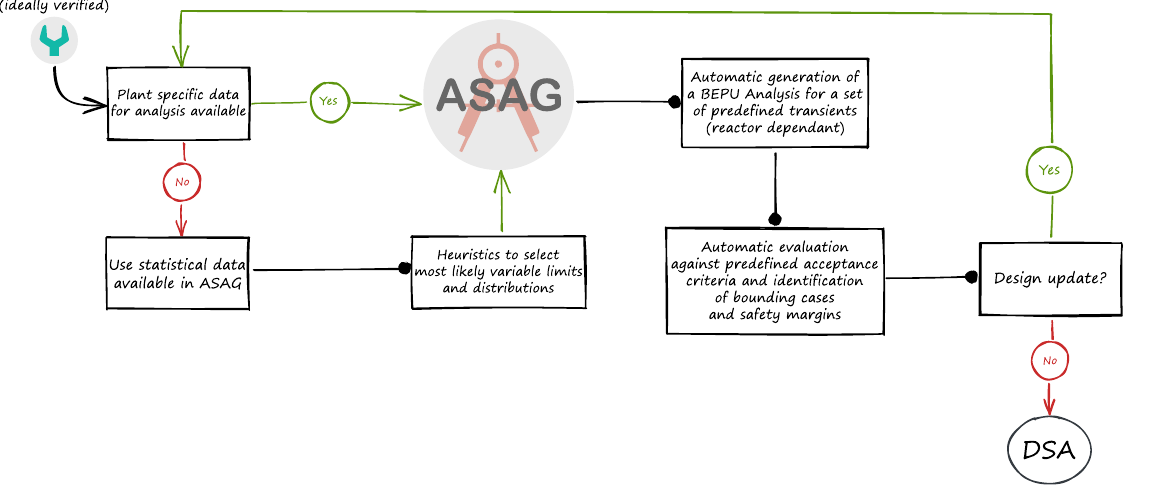
Fig. 6. Flow diagram for the Automatic Safety Analysis Generator